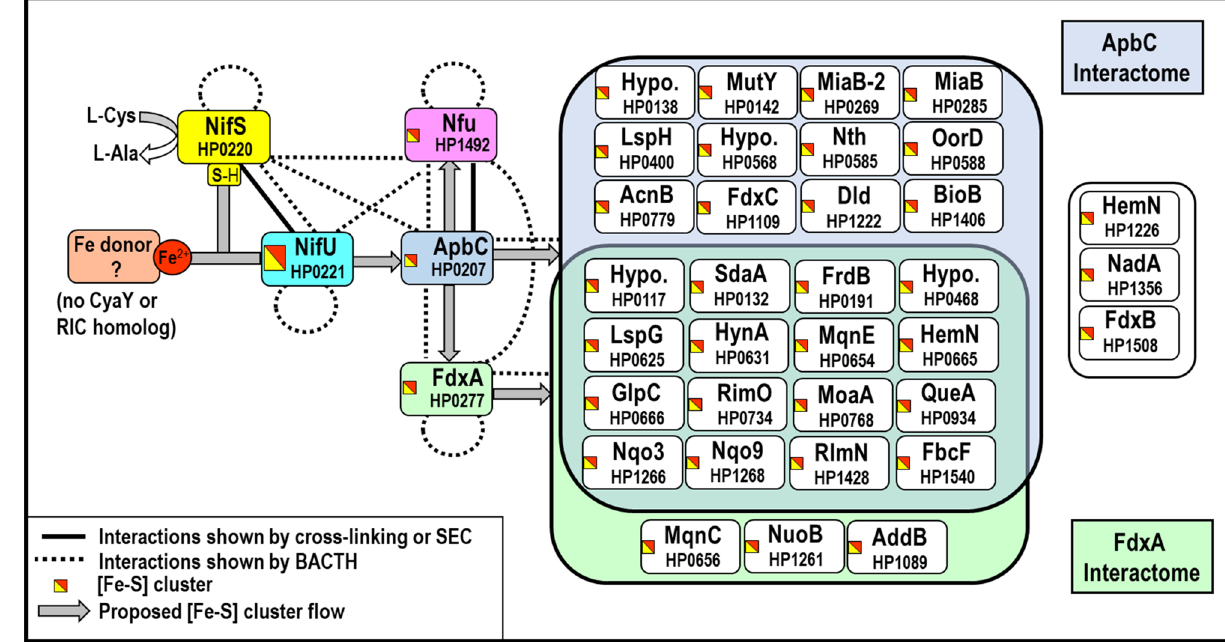
Figure 4. Proposed model for [Fe–S] clusters homeostasis in H. pylori and summary of interactions involving ApbC (HP0207) and FdxA (HP0277). Sulfur (originating from NifS) and iron (free, or brought by a protein yet to be identified) are assembled as [Fe–S] clusters on the NifU scaffold protein (or alternatively on ApbC) and subsequently distributed via three Fe–S carrier proteins, ApbC, FdxA and Nfu; and eventually to [Fe–S] cluster recipient proteins. Based on BACTH (screening and selection) results, proteins found to interact with either ApbC or FdxA are shown in respective interaction balloons. Proteins shown on the right were not found to interact with any of the bait proteins. NifS, NifU and Nfu interactomes have been previously described 29